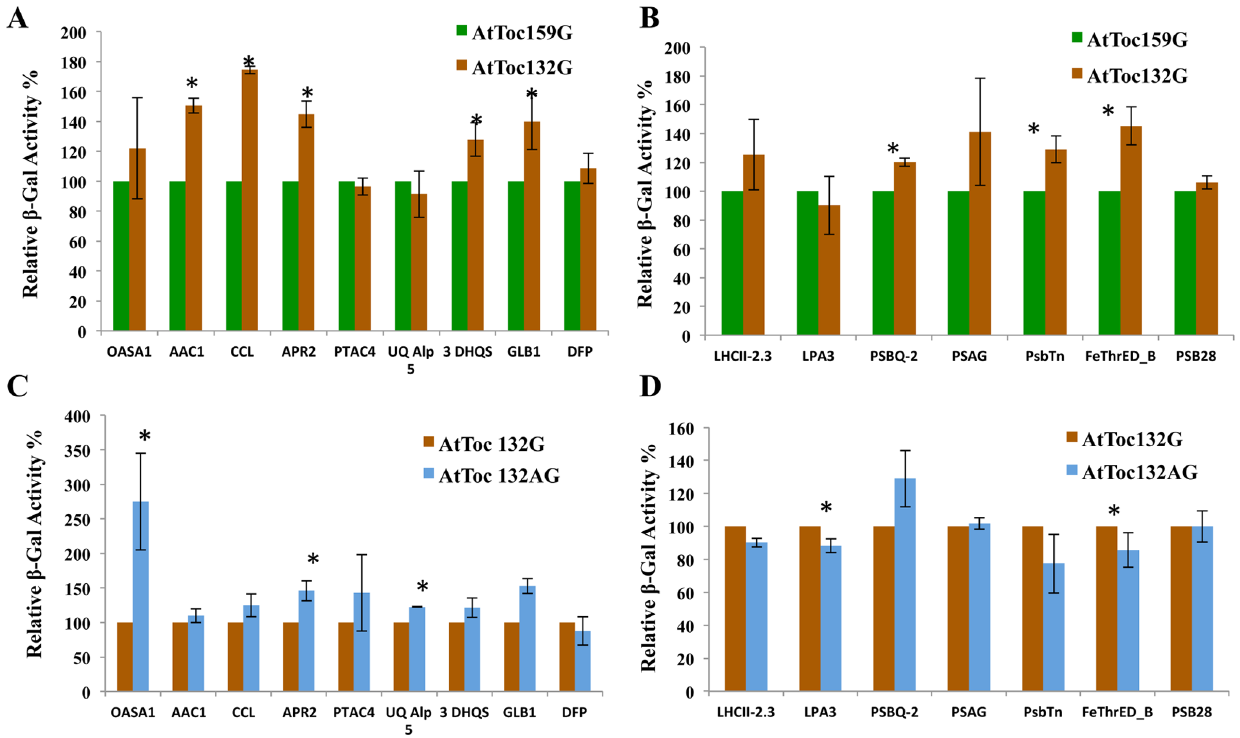
Figure 5. Comparative strengths of protein–protein interactions as determined by a quantitative b -galactosidase assay for additional prey proteins isolated from the screen using atToc132AG as the bait. (A–D) Relative enzymatic activity of b -Gal in extracts from S. cerevisiae strain NMY51 that expressed atToc159G, atToc132G or atToc132AG-domain bait and also carried NubG-Prey construct as indicated in Table 1 and 2. Yeast cells were grown to A 546 of , 0.8 in SD ( 2 Leu, 2 Trp) medium at 30 u C, followed by measurements as described in materials and methods, and quantified according to the following formula: Activity=1,000 6 OD 615 /V 6 t 6 OD 546 , were V is the volume of assay and t is the time of incubation. For b -Gal activity in cell extracts, the measured activity was normalised to that of mock co-transformed strains containing atToc159G, atToc132G or atToc132AG bait and empty vector, pR3-N for respective interactions. A relative b -Gal activity of 100% was arbitrarily assigned to the atToc159G bait containing (A–B) and atToc132G bait containing (C–D) pairwise interactions. The experiments were performed in triplicate and repeated at least twice. Error bars indicate 6 SD. Values marked with asterisks are significantly different (Student’s t-test; P # 0.05). (A) Interaction in yeast co-expressing atToc159G or atToc132G bait and additional non-photosynthetic prey interactors identified in the screen using atToc132AG as the bait (Table 1). (B) Interaction in yeast co-expressing atToc159G or atToc132G bait and additional photosynthetic prey interactors identified in the screen using atToc132AG screening (Table 2). (C) Interaction in yeast co-expressing atToc132G or atToc132AG bait and additional non-photosynthetic prey interactors identified in the screen using atToc132AG screening (Table 1). (D) Interaction in yeast co-expressing atToc132G or atToc132AG bait and additional non-photosynthetic prey interactors identified in the screen using atToc132AG screening (Table